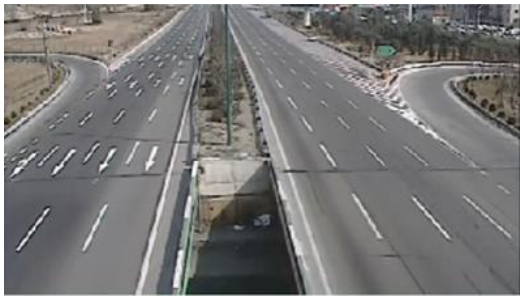
Figure 6: Barescene generation using median